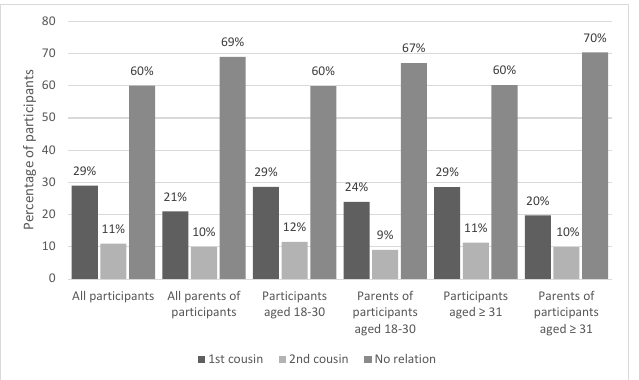
Figure 2. Comparison of prevalence of CM according to the ages of the participants and those of their parents. 3.3. Incidence of Hereditary Diseases and Health ‐ Related Issues Associated with CM Of the pre ‐ selected screening panel for hereditary diseases and health ‐ related issues among participants, which involved 17 items, CVDs ( p < 0.001), blood diseases ( p < 0.001), cancer ( p = 0.046), hearing loss and speech disorders ( p = 0.003), and ophthalmic diseases ( p = 0.037) were significantly associated with CM. Of the participants’ children, 92% of those with CVDs were found to have related parents. The percentage of occurrence of blood diseases among children of related parents was 3 times higher than that among children of unrelated parents (79% and 21%, respectively). Cancer was reported in 2% of